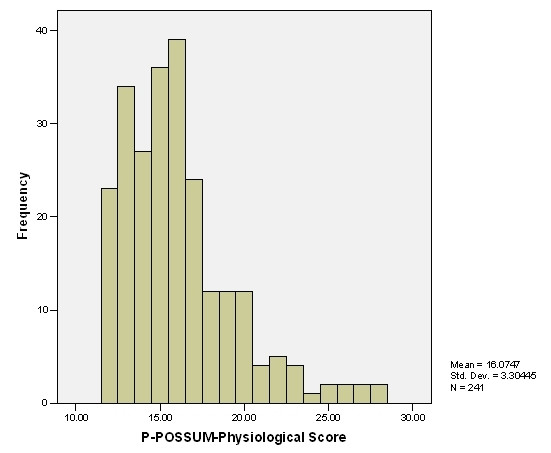
Distribution of patients according to Physiological Score.